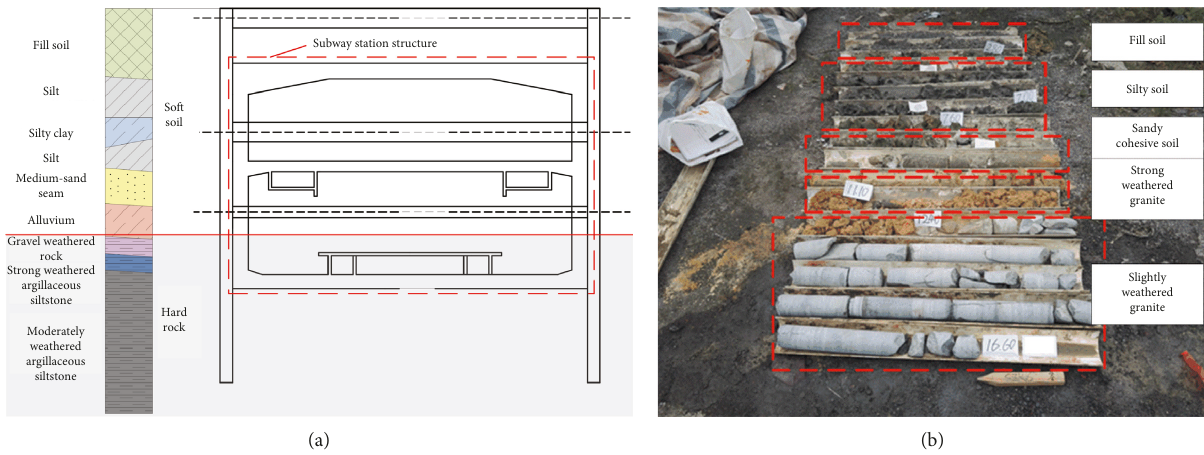
Figure 1: Large-span and column-free subway station in composite strata. (a) The proposed subway station and its surrounding strata. (b) On-site drilling of soil